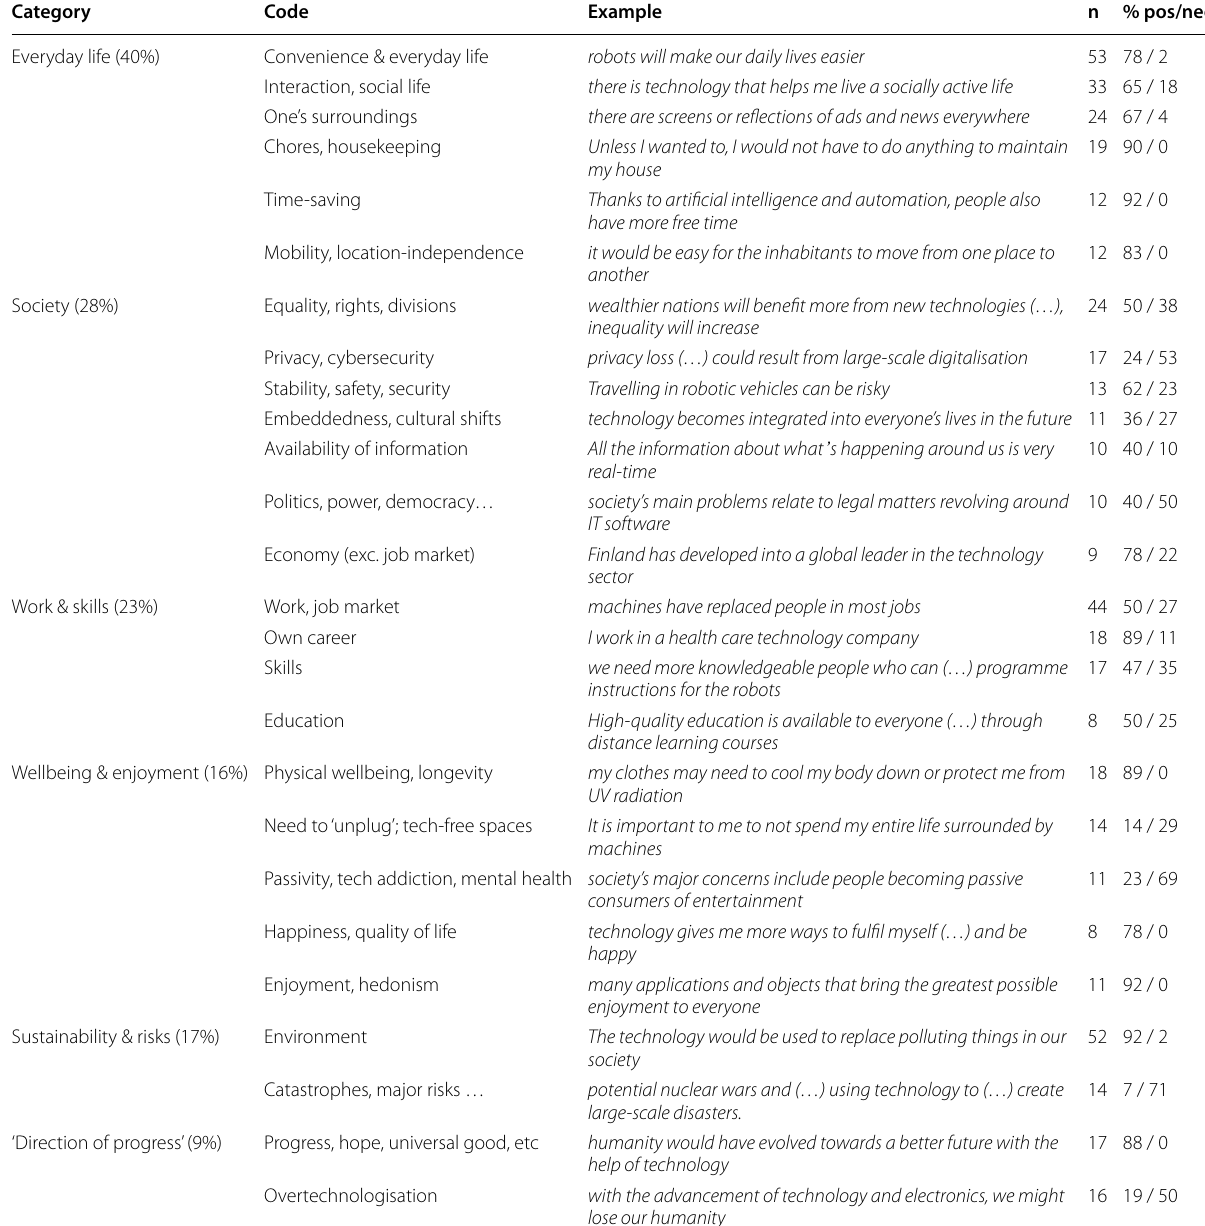
Table 2 Effect codes grouped into categories, with examples, number of occurrences and percentages of positive and negative